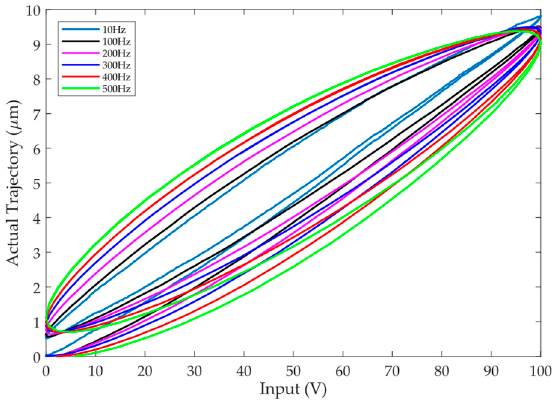
Figure 2. The hysteresis loops of the piezoelectric actuator (PEA) at different frequencies, showing the rate ‐ dependence.